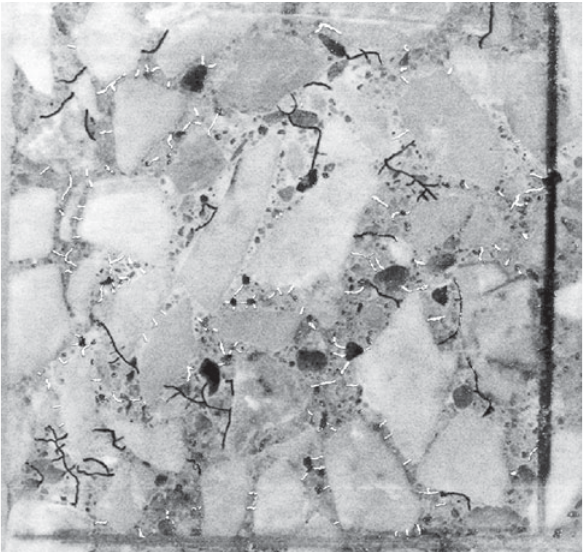
Figura 3. Microcracking in Uniaxial Tension. White lines: mortar cracks; black lines: combined